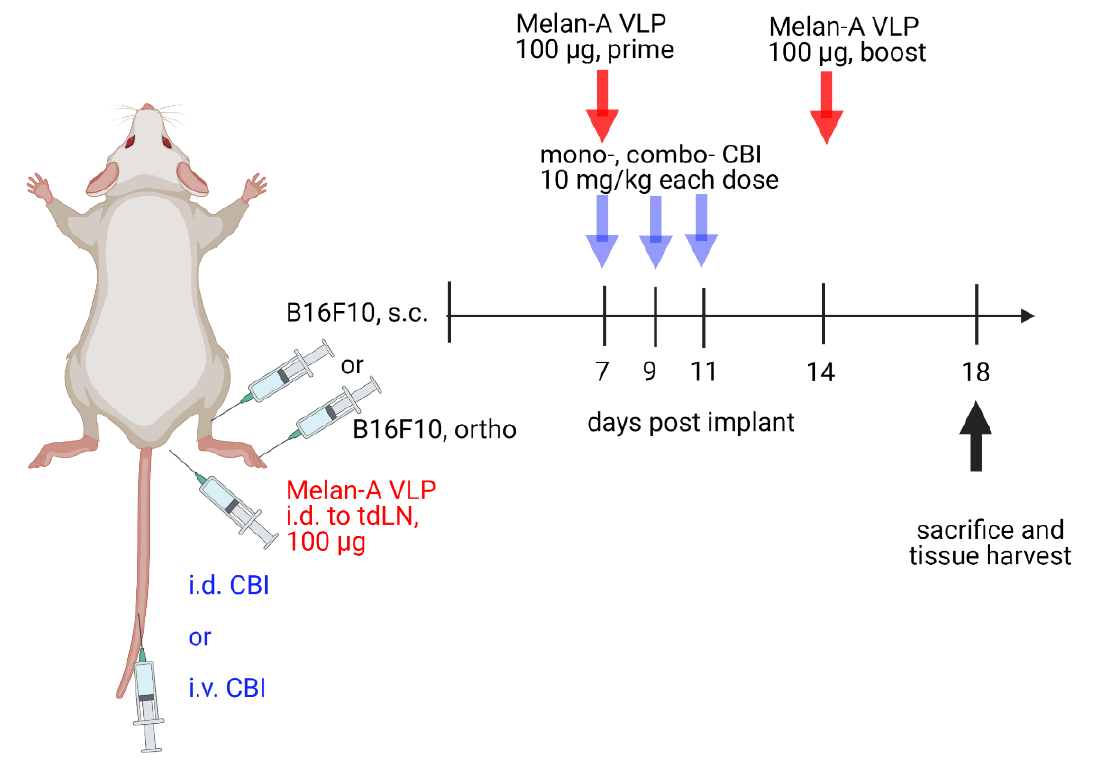
Figure 2. Orthotopic mouse models for melanoma B16F10 cell inoculation in hindlimb and dorsal aspect of hind paw and timeline for checkpoint blockade immunotherapy (CBI) dosing and sacrifice. i.d., intradermal; i.v. intravenous; s.c., subcutaneous; ortho, orthotopic. Created with Biorender.com (accessed on 21 February 2022).